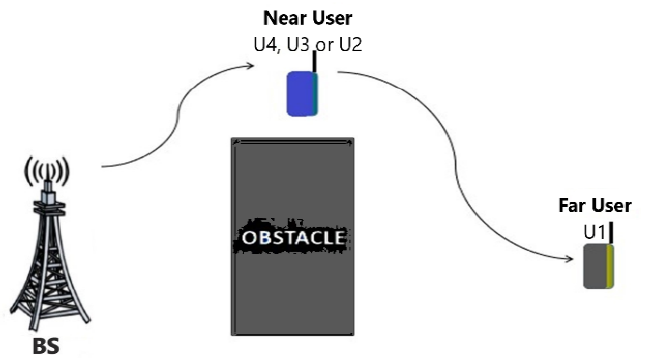
Figure 4. Cooperative SWIPT hybrid THz NOMA model .